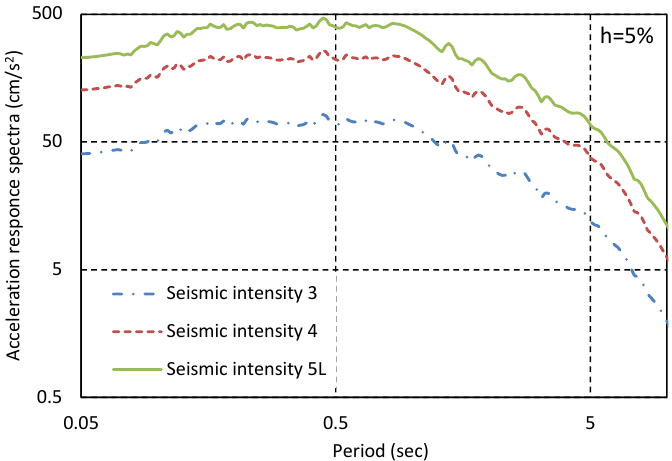
Figure 2. Acceleration response spectra of each seismic intensity wave. Table 1. Maximum number of occurrences of each seismic intensity over 30 years.